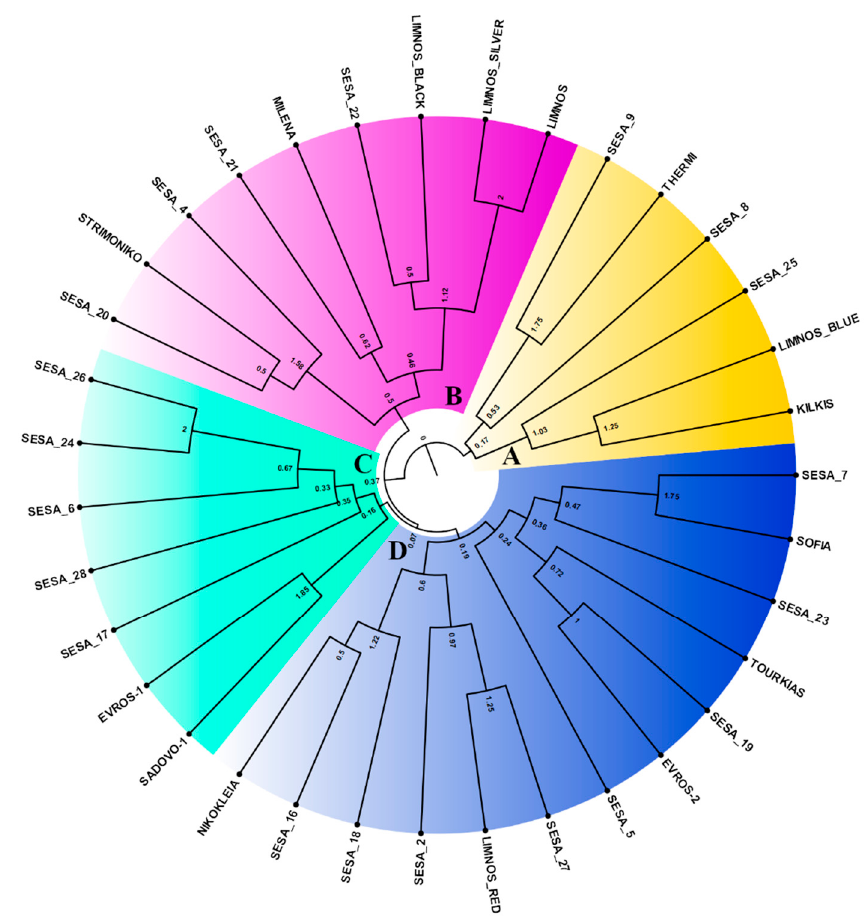
Figure 6. Unweighted Pair Group Method with Arithmetic mean (UPGMA) dendrogram of the 35 sesame landraces based on the genetic distance matrix derived from the EST-SSR data. The formed clades of the sesame landraces were color-coded (clade A: yellow, clade B: magenta, clade C: cyan, clade D: blue).